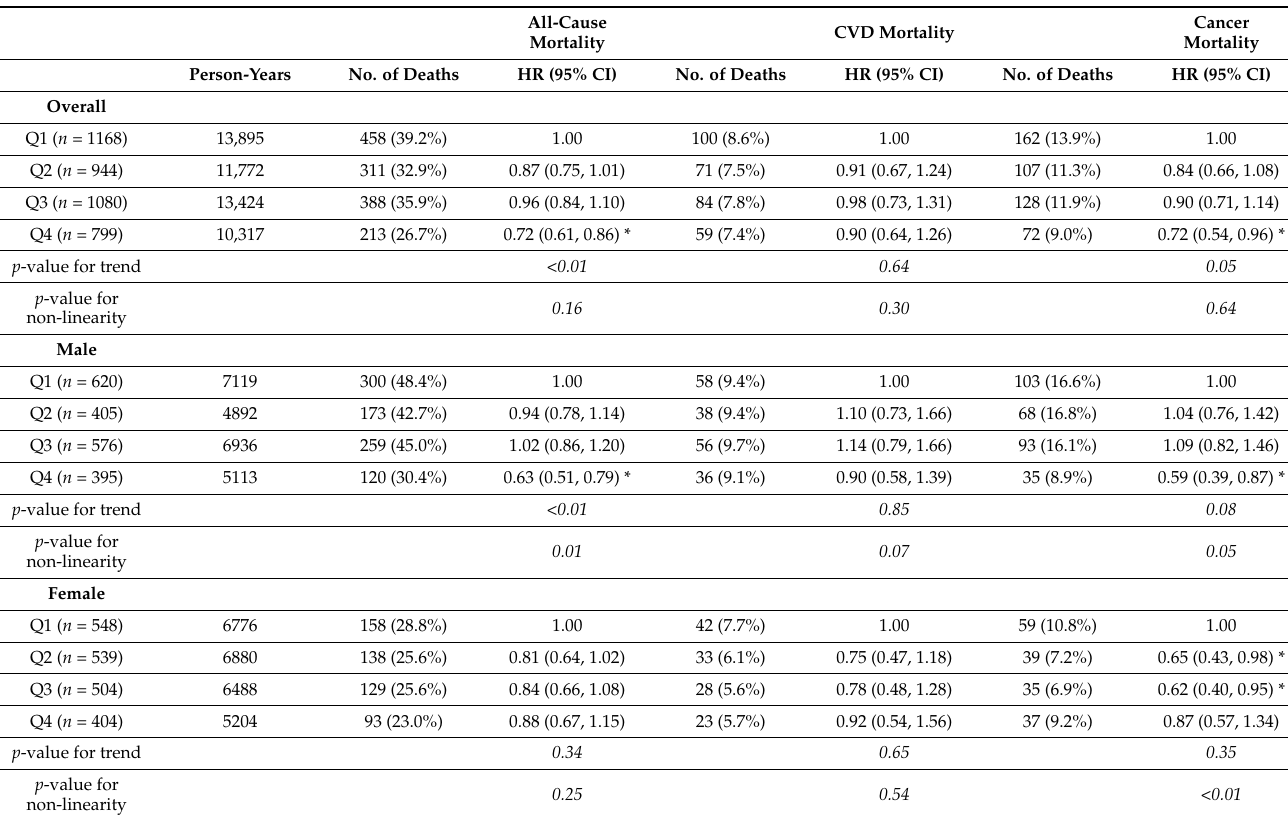
Table 3. Prospective association of the Portfolio Diet Score with the risk of mortality outcomes among 3991 participants in Mr. OS and Ms. OS Study.